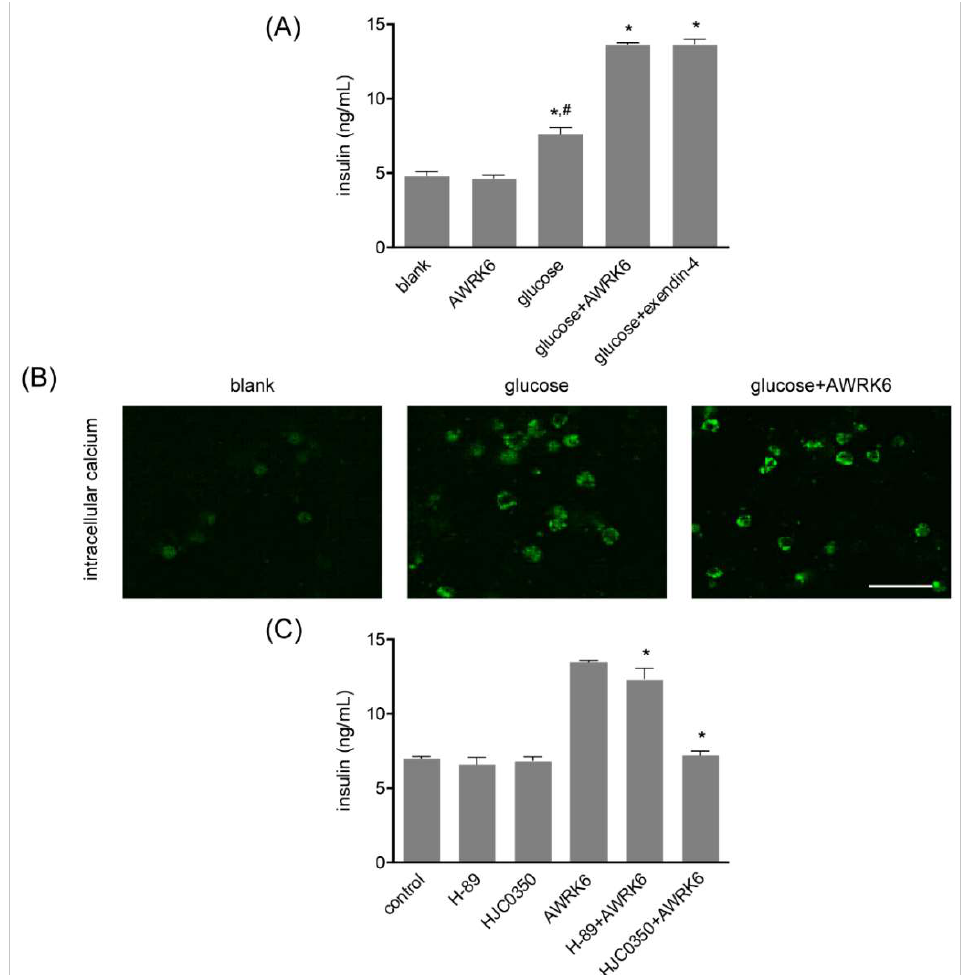
Figure 4. AWRK6 induced insulin in a cAMP-dependent manner. ( A ) The insulin secretion in Min6 cells treated with AWRK6, analyzed by ELISA. ( B ) The intracellular calcium in Min6 cells treated with AWRK6, determined using Fluo 3-AM. ( C ) The insulin secretion in Min6 cells treated with AWRK6, protein kinase A (PKA) inhibitor H-89, and Epac2 inhibitor HJC0350. * p < 0.05 compared with the glucose group for A, B, and compared with the AWRK6 group for C; # p < 0.05 compared with the blank group. The error bar indicates standard deviation. Scale bar indicates 100 μm.